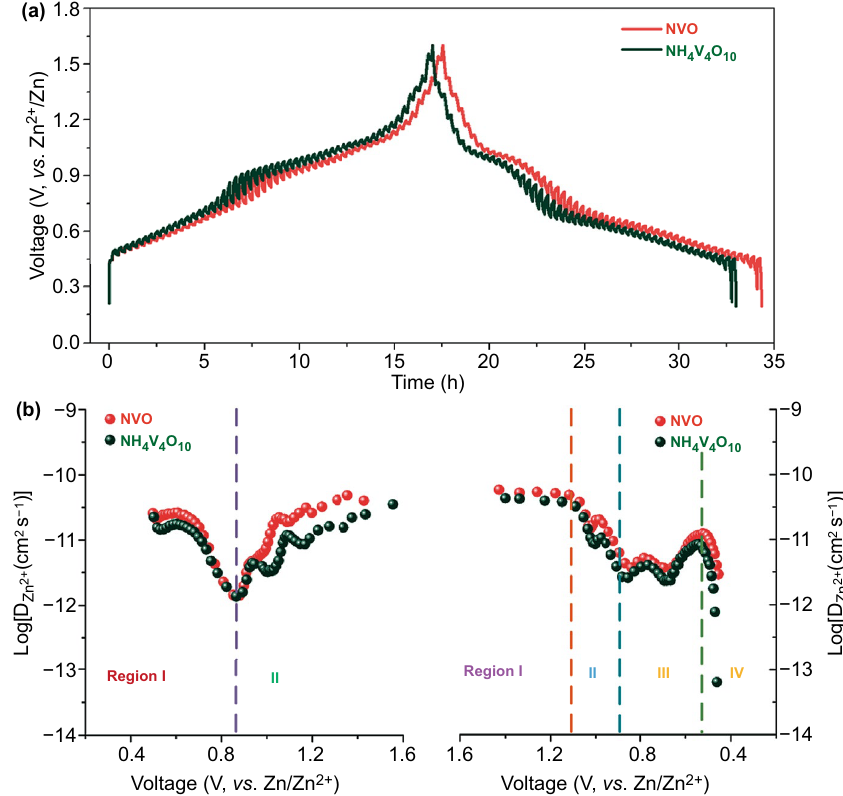
Fig. 6 Analysis of ions insertion/extraction process. a GITT tests at a current density of 50 mA h g −1 . b Corresponding ion diffusion coefficients of NVO and NH 4 V 4 O